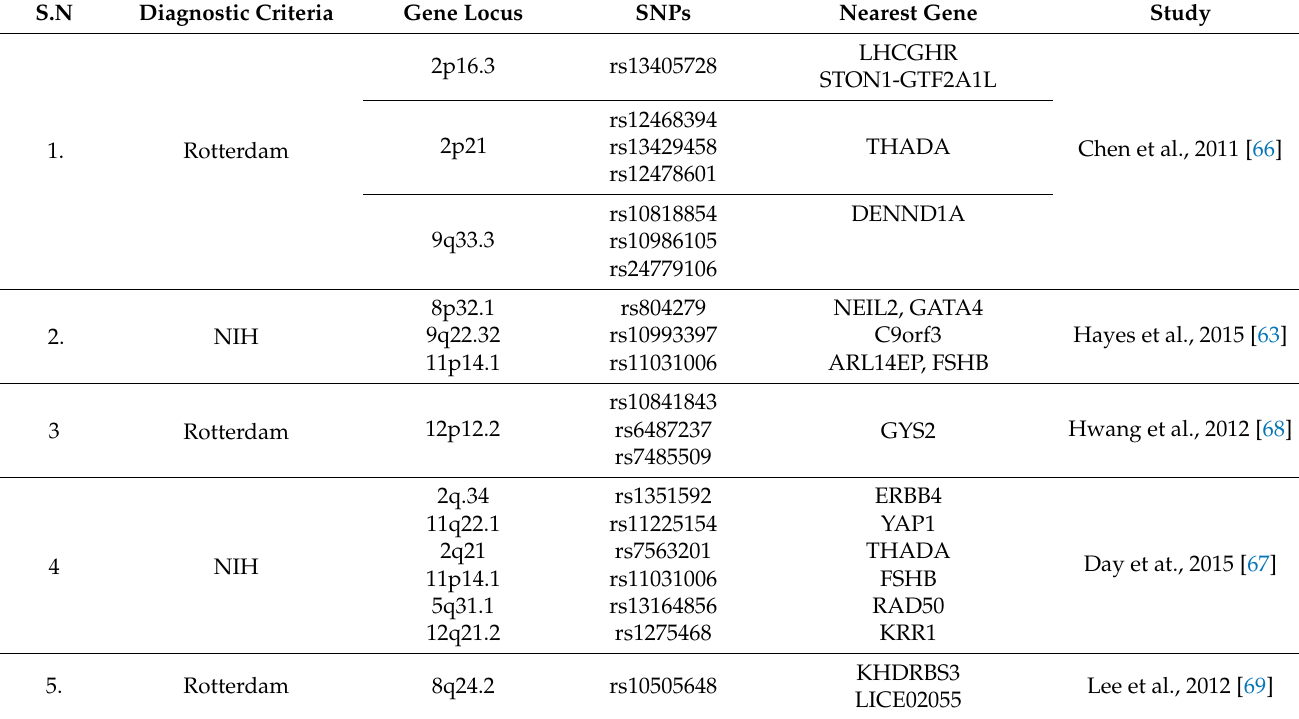
Table 3. Single Nucleotide Polymorphism Identified by Different GWAS Studies in